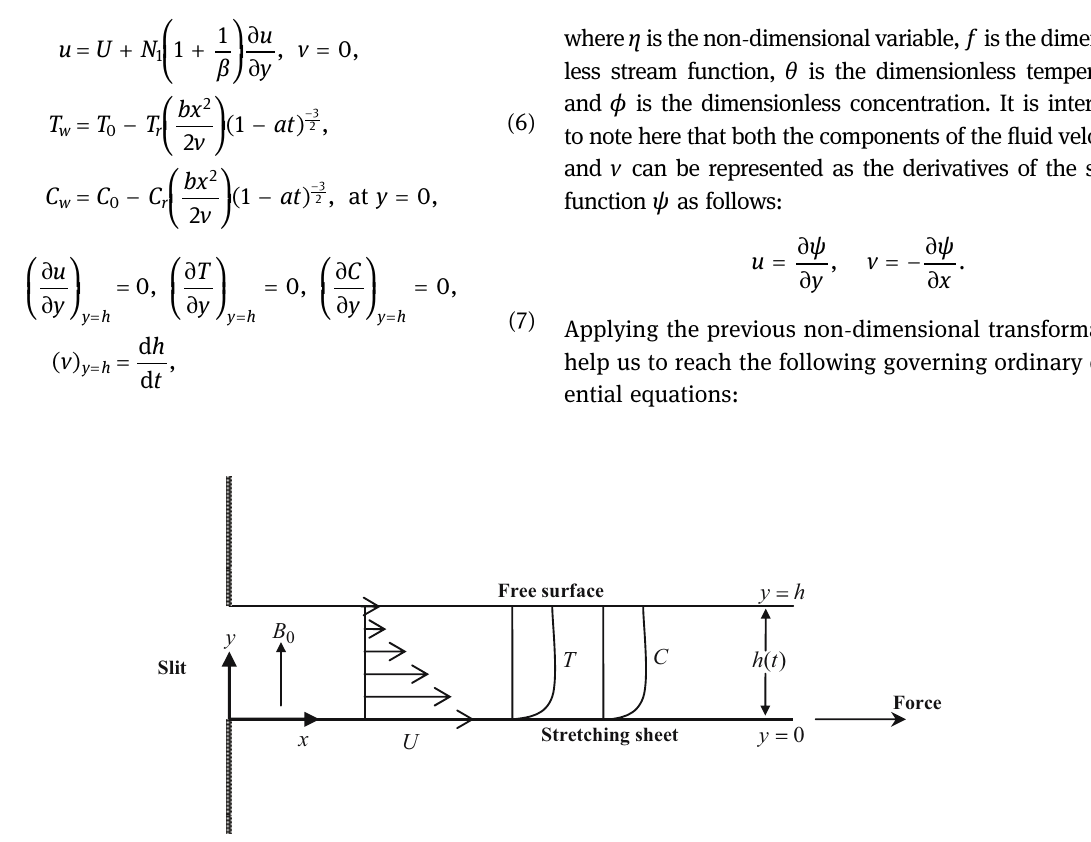
Figure 1: Physical con fi